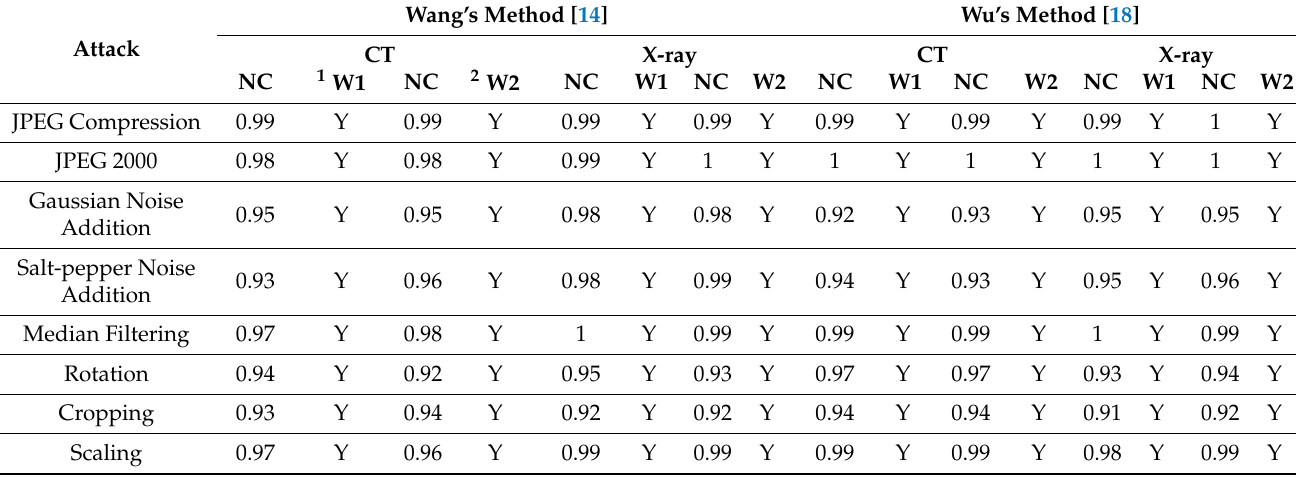
Table 4. The simulated results of medical images after various attacks with other lossless image watermarking systems.